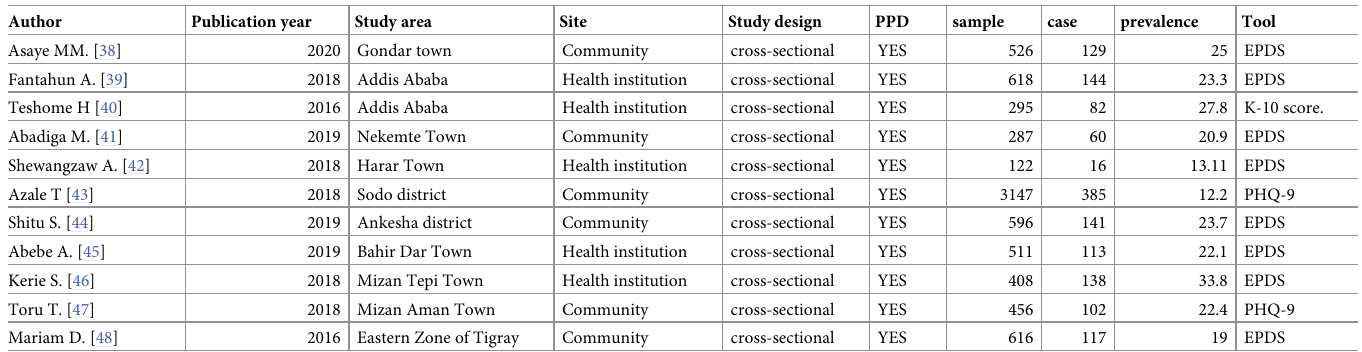
Table 1. The prevalence of post-partum depression among women related to the study area in Ethiopia, 2020.